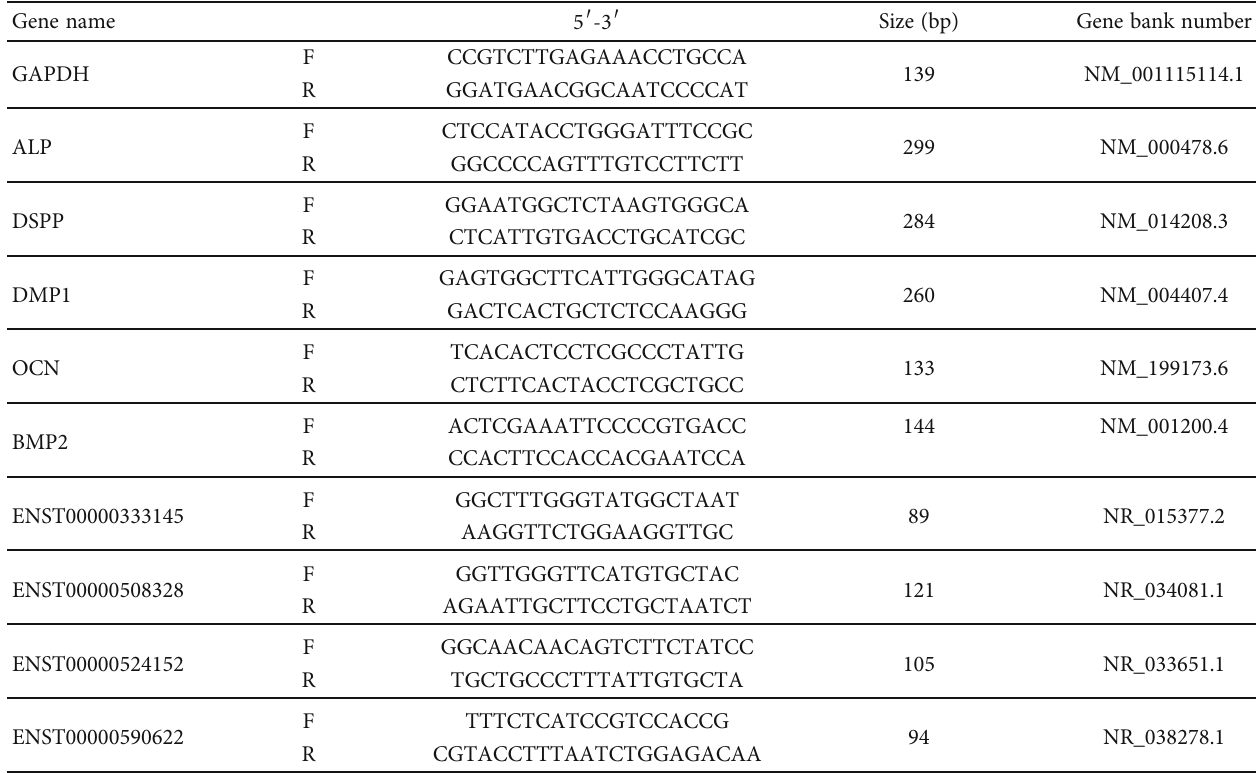
Table 1: Sets of primers used in